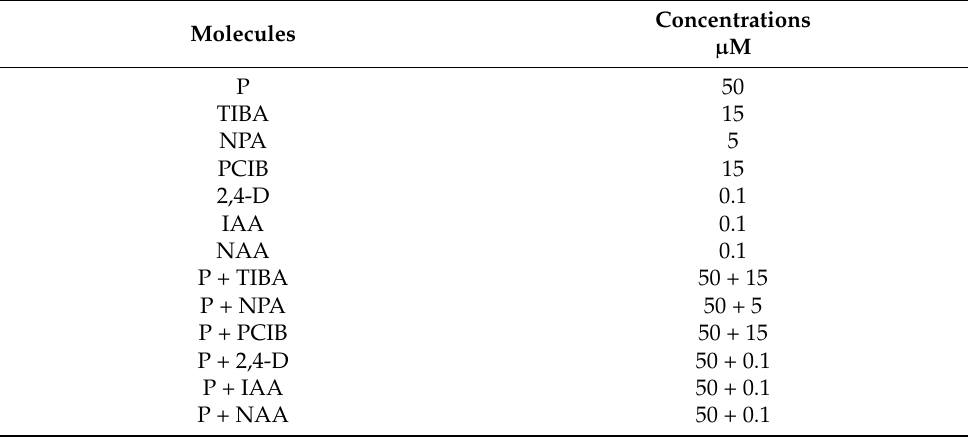
Table 1. Concentrations of natural/synthetic auxins, transport inhibitor, anti-auxin and/or proto- dioscin (P) used in the interaction